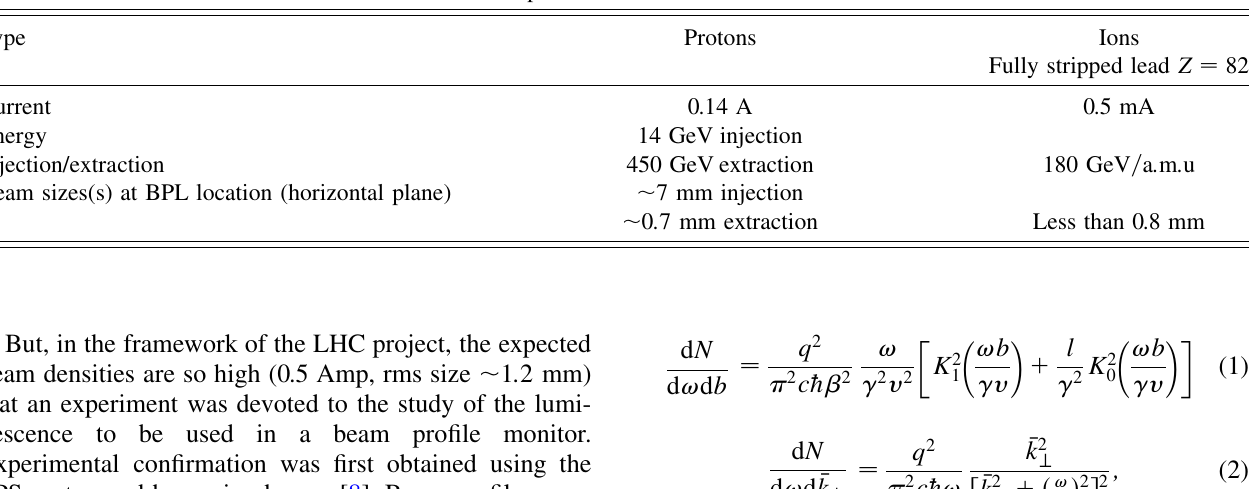
TABLE I. Experimental beams